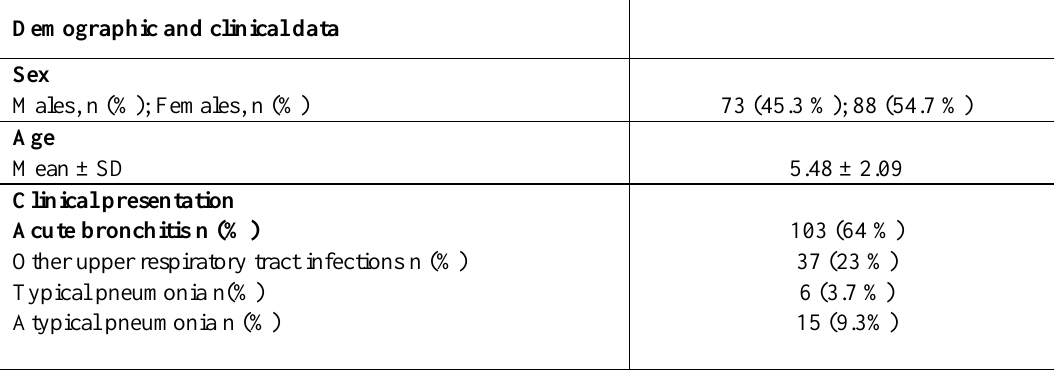
Table 1. Demographic and clinical data of children with respiratory tract